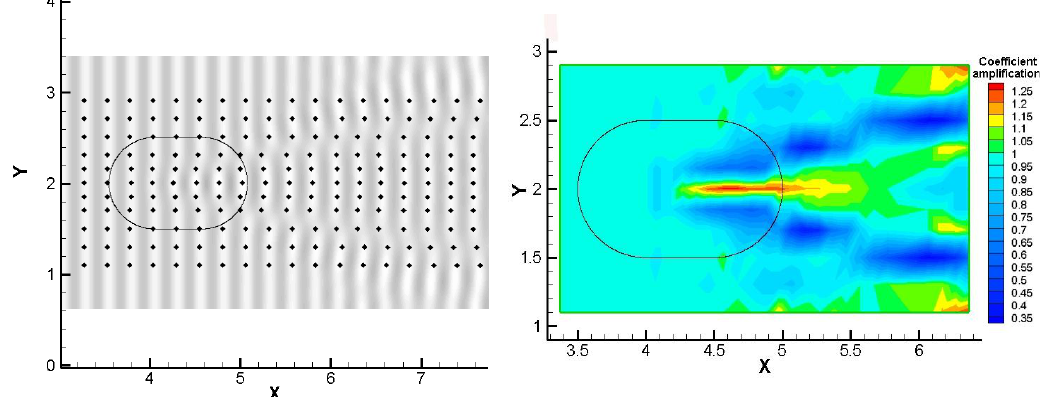
Fig. 8: Wave phase (left) and amplitude (right) measurements, T=0.4s